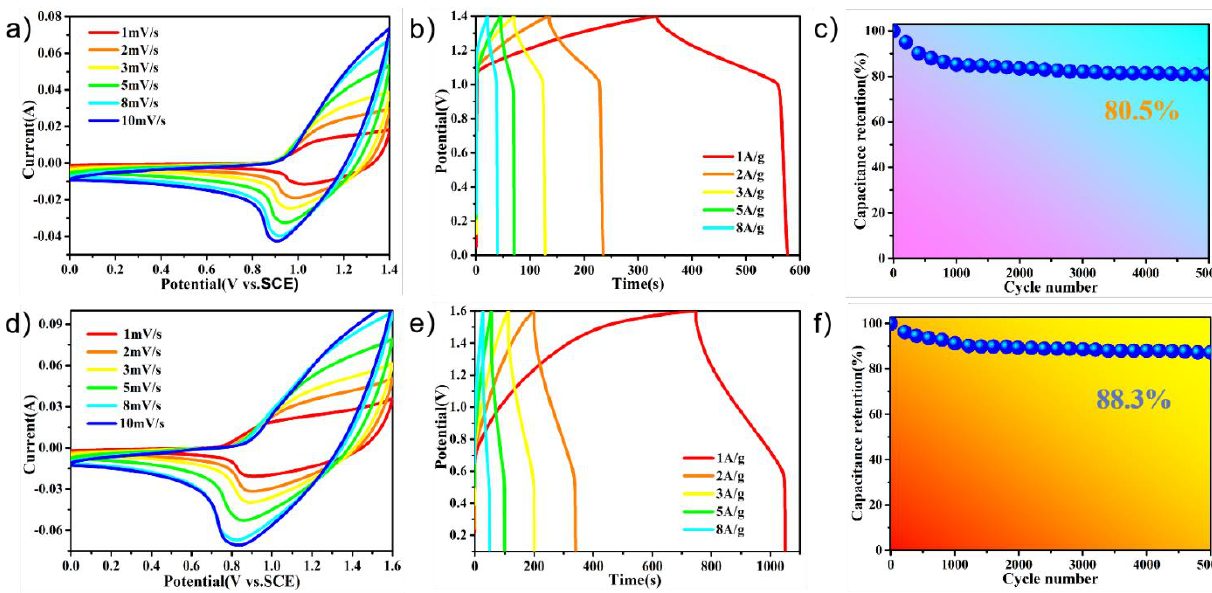
Figure 6. ( a ) CV curves of PPy@FeNi 2 S 4 @NF − 6//AC asymmetric supercapacitor at various sweeping rates. ( b ) GCD curves of PPy@FeNi 2 S 4 @NF − 6//AC asymmetric supercapacitor at various current